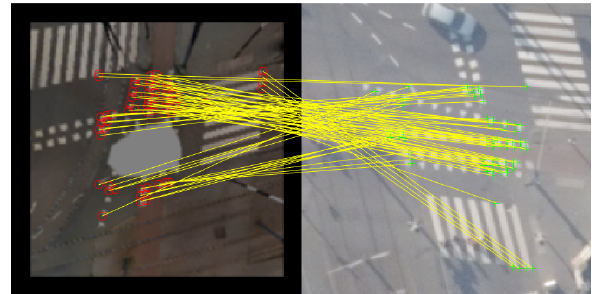
Figure 11. Test area 3; 69 correct correspondences between MM and aerial